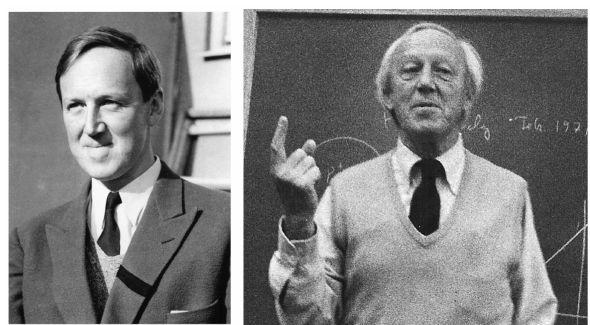
Figure 1. Images of Hannes Alfvén as a young man (age 34) and